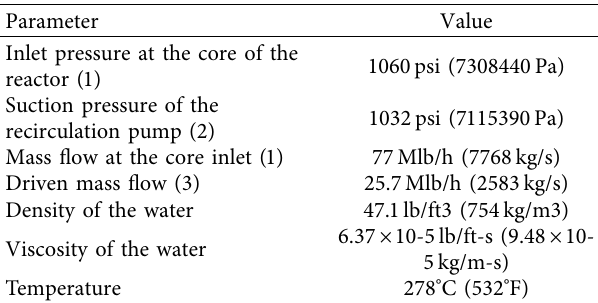
Figure 2: Model of the jet pump assembly. Table 1: Parameters of operation